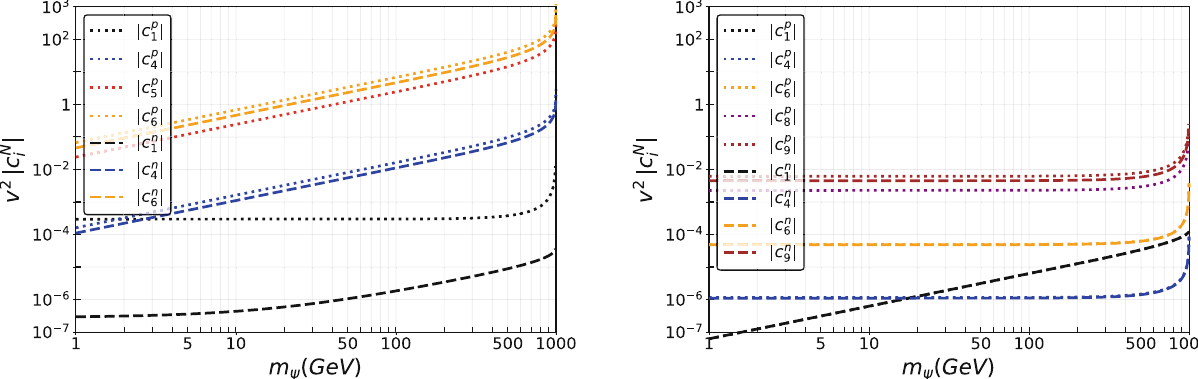
Fig. 3 Non-relativistic nucleon level Wilson coefficients evaluated for 132 Xe at E R = 8 . 59 keV (and thus |(cid:12) q | 2 = 2 . 11 × 10 − 3 GeV) versus 54 the DM mass m ψ . The Higgs portal coupling is λ HS = 3. All Wilson